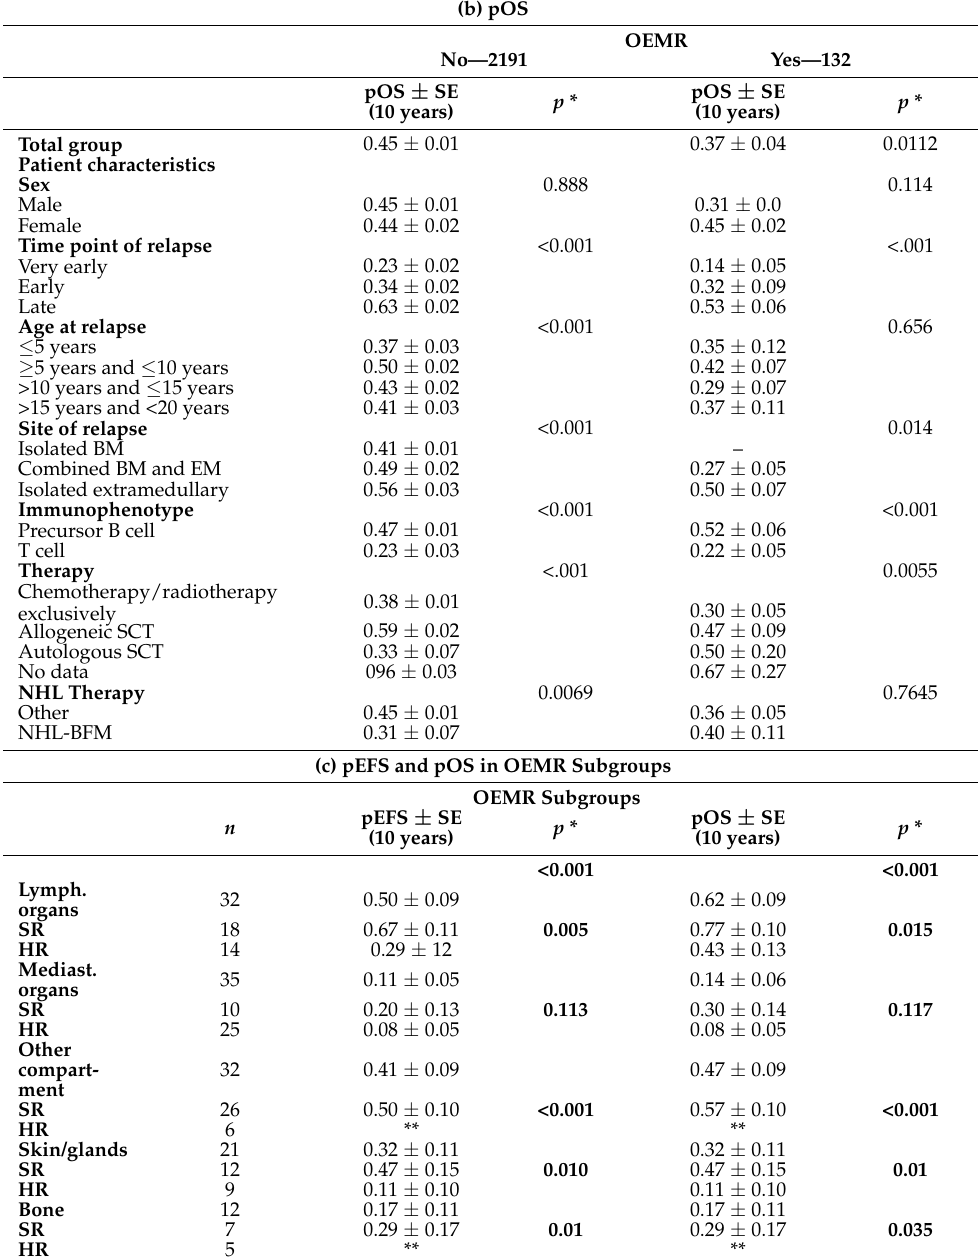
Legend to Table 5: * Log-rank test and pairwise log-rank test, missing values excluded. ** Ten-year pEFS and pOS not reached. Abbreviations: BM, bone marrow; EM, extramedullary; HR, high risk; NHL-BFM, Non-Hodgkin’s Lymphoma Berlin–Frankfurt–Munster protocol; OEM(R), other extramedullary (relapse); pEFS, probability of event-free survival; pOS probability of overall survival; SCT, stem cell transplantation; SE, standard error; SR, standard